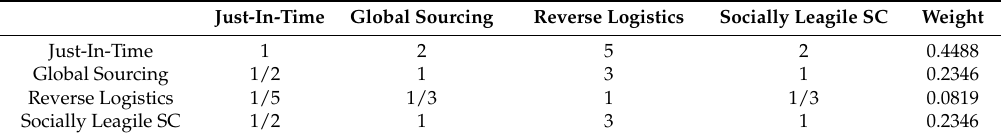
Table A11. Pairwise Comparison of Alternative w.r.t. sub-criterion Time Efficiency.